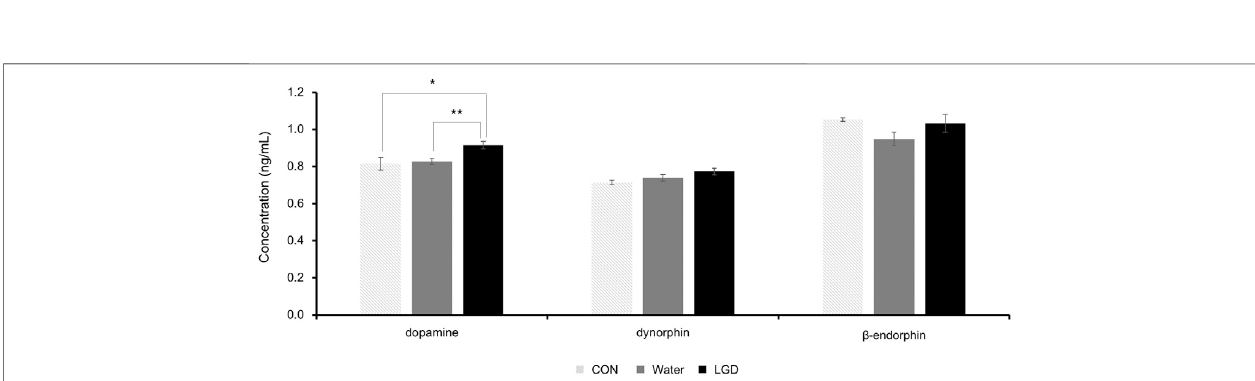
Frontiers in Pharmacology |